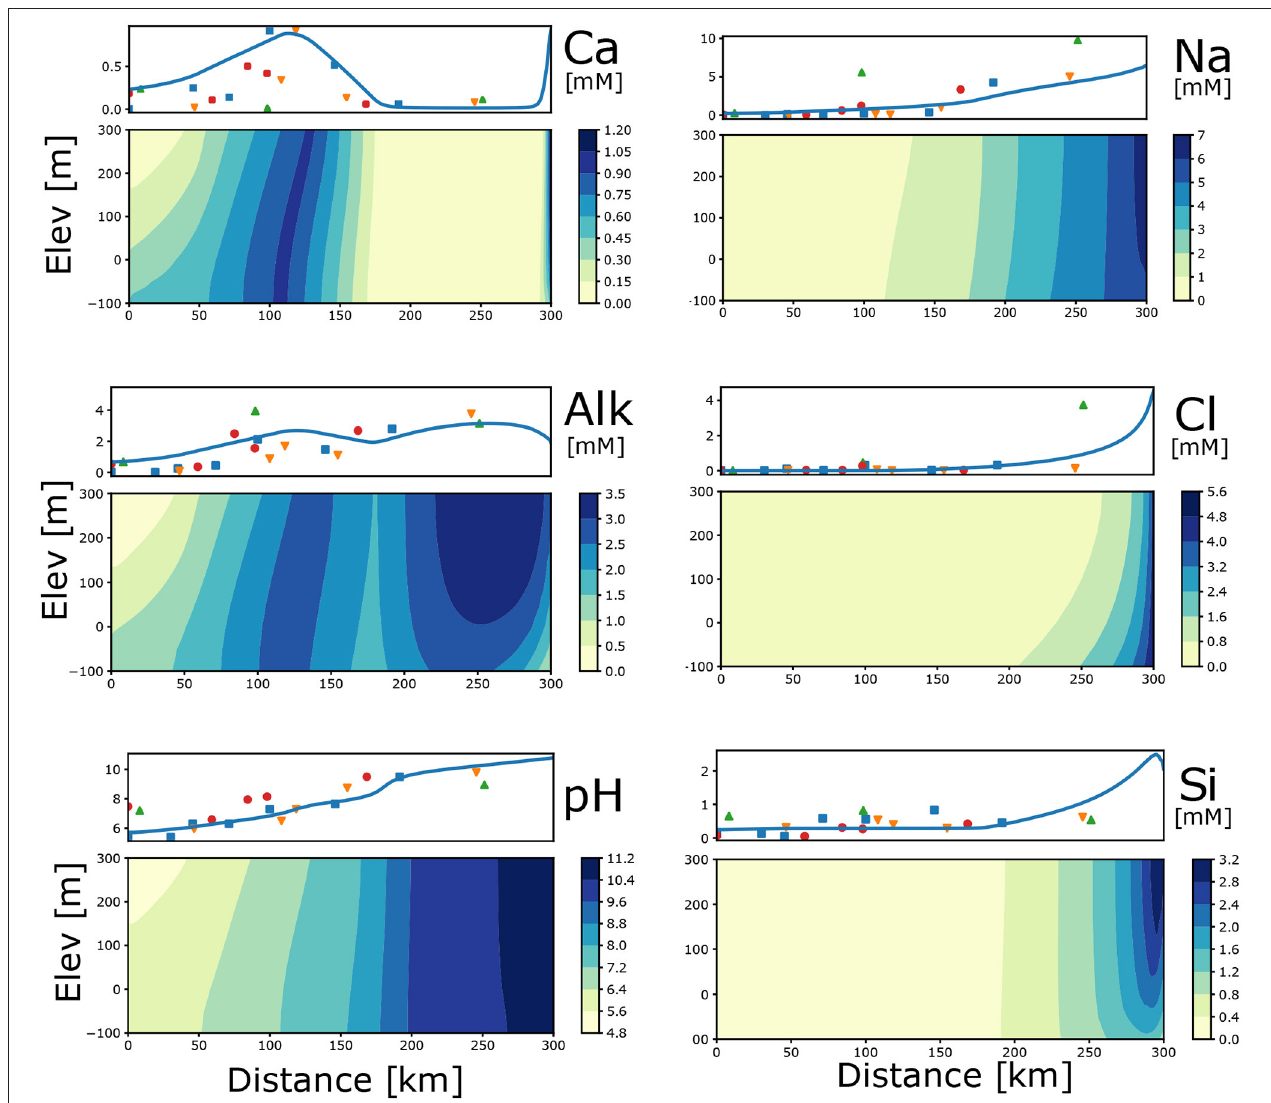
FIGURE 2 | Profile average (measured and modelled) and 2D distribution of concentrations (mM) and pH due to plagioclase hydrolysis and associated secondary reactions. Input parameters for the model are: Rech_0 = 0.0025, Rech_50 = 0.0002, Kx = 0.33, Kz = 0.033, pCO2 = –1.5, log r_Plag = –17.22, log K Cal = –8.48, n = 0.22, CEC = 2.5. Different symbols for measured data indicate separate flow